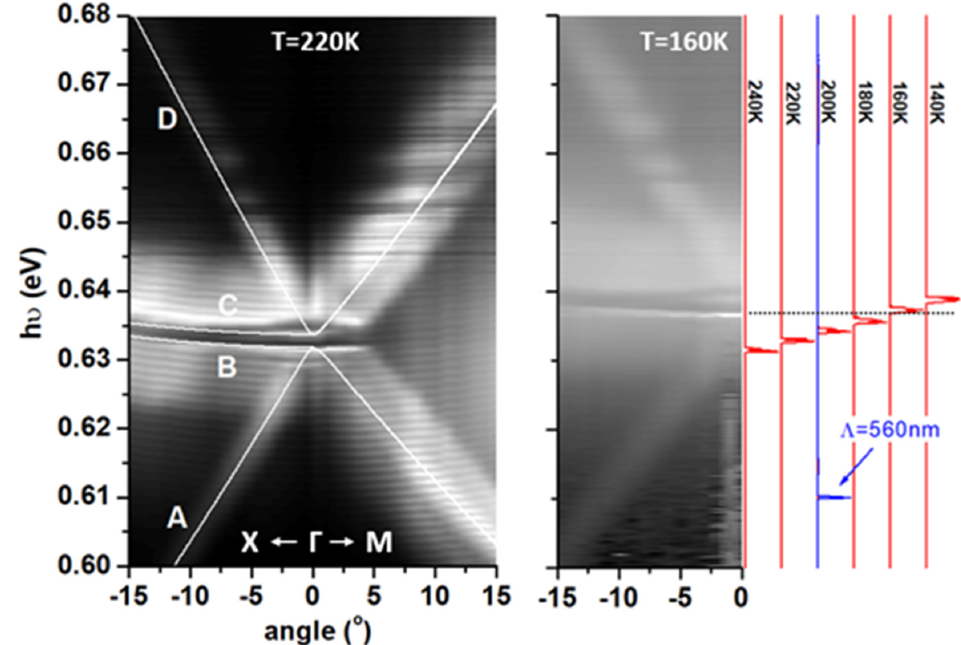
Figure 3. The |photon energy| vs. |surface emission angle| intensity maps measured in the pulsed regime (100 ns, 8 MHz) at 220 K and 170 mA in X and M directions (left), and in X direction at 160 K at 30 mA (right). The corresponding PCSEL (period 540 nm) emission spectra (100 ns, 100 kHz) measured at 800 mA and at different temperatures are shown on the right. The 200 K emission spectrum of the PCSEL with a 560 nm period is also shown.